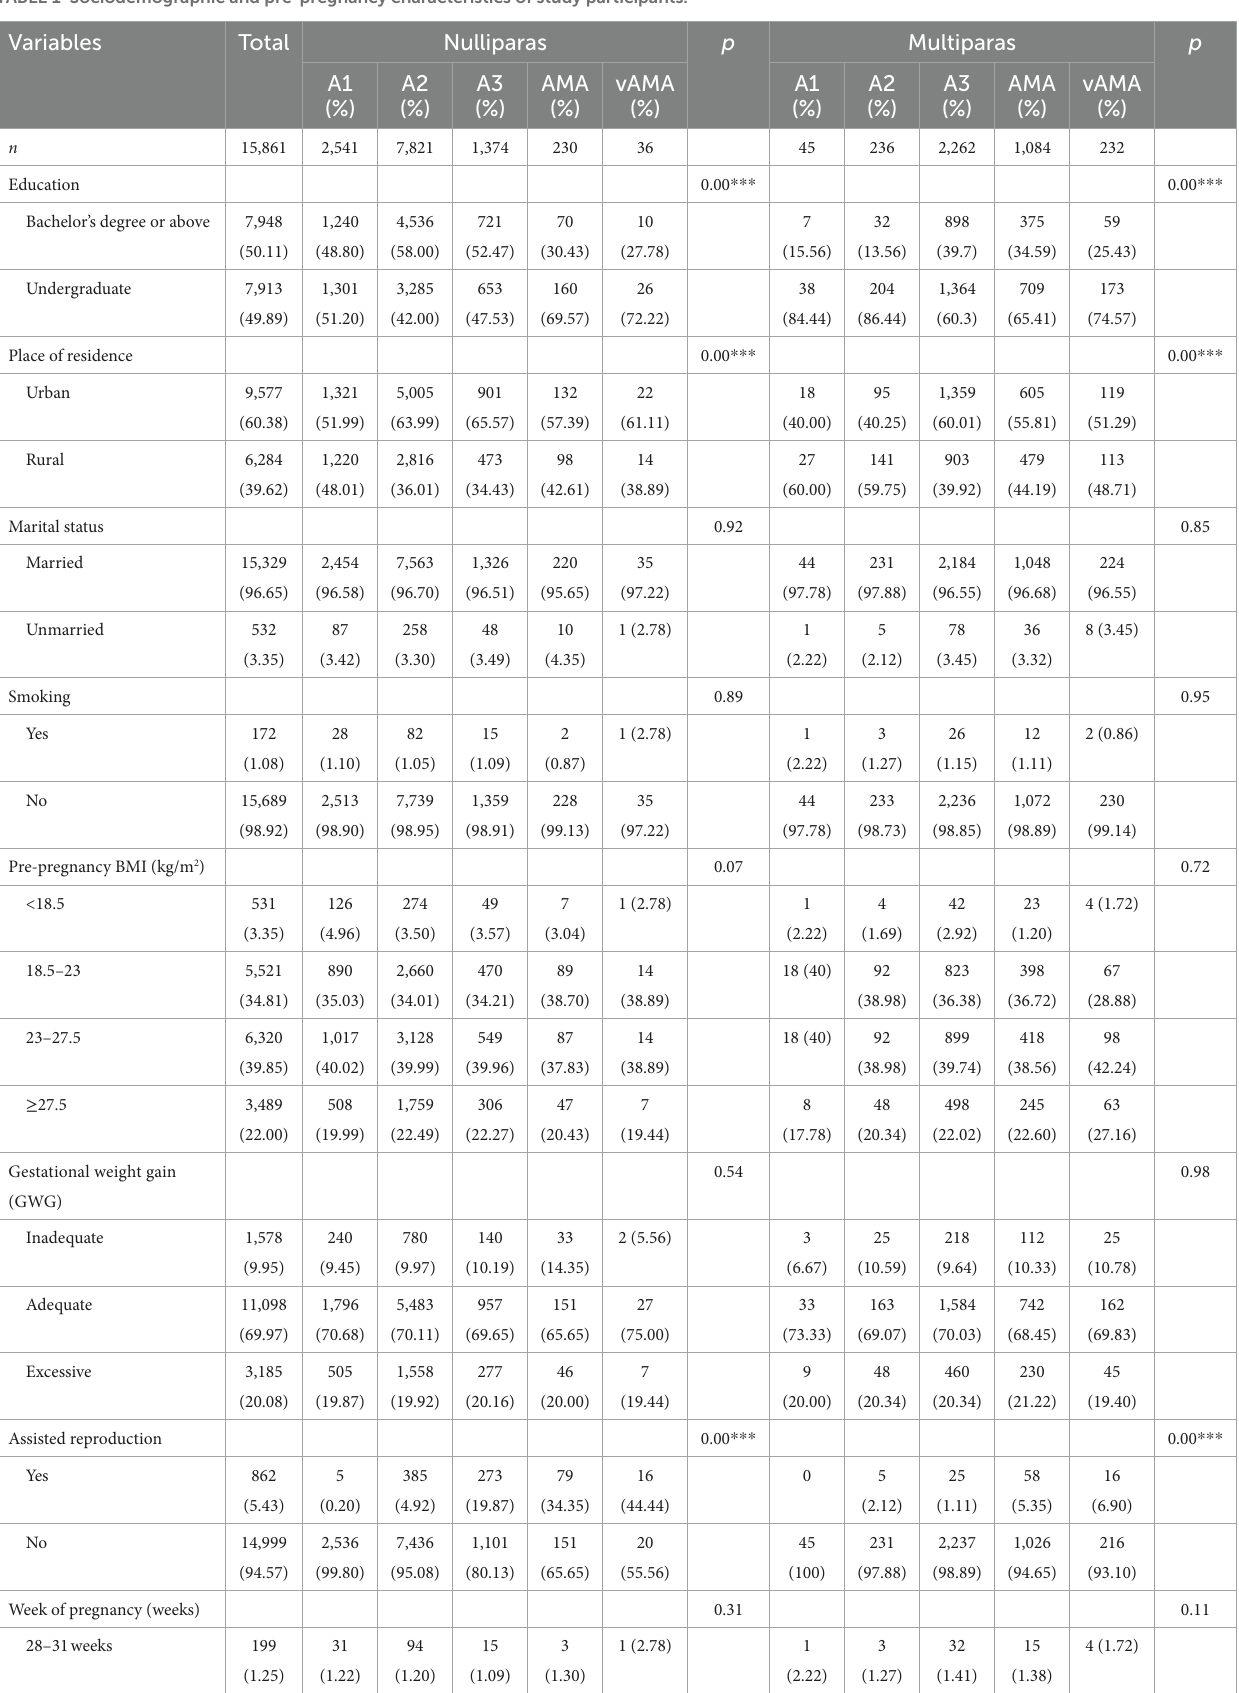
TABLE 1 Sociodemographic and pre-pregnancy characteristics of study